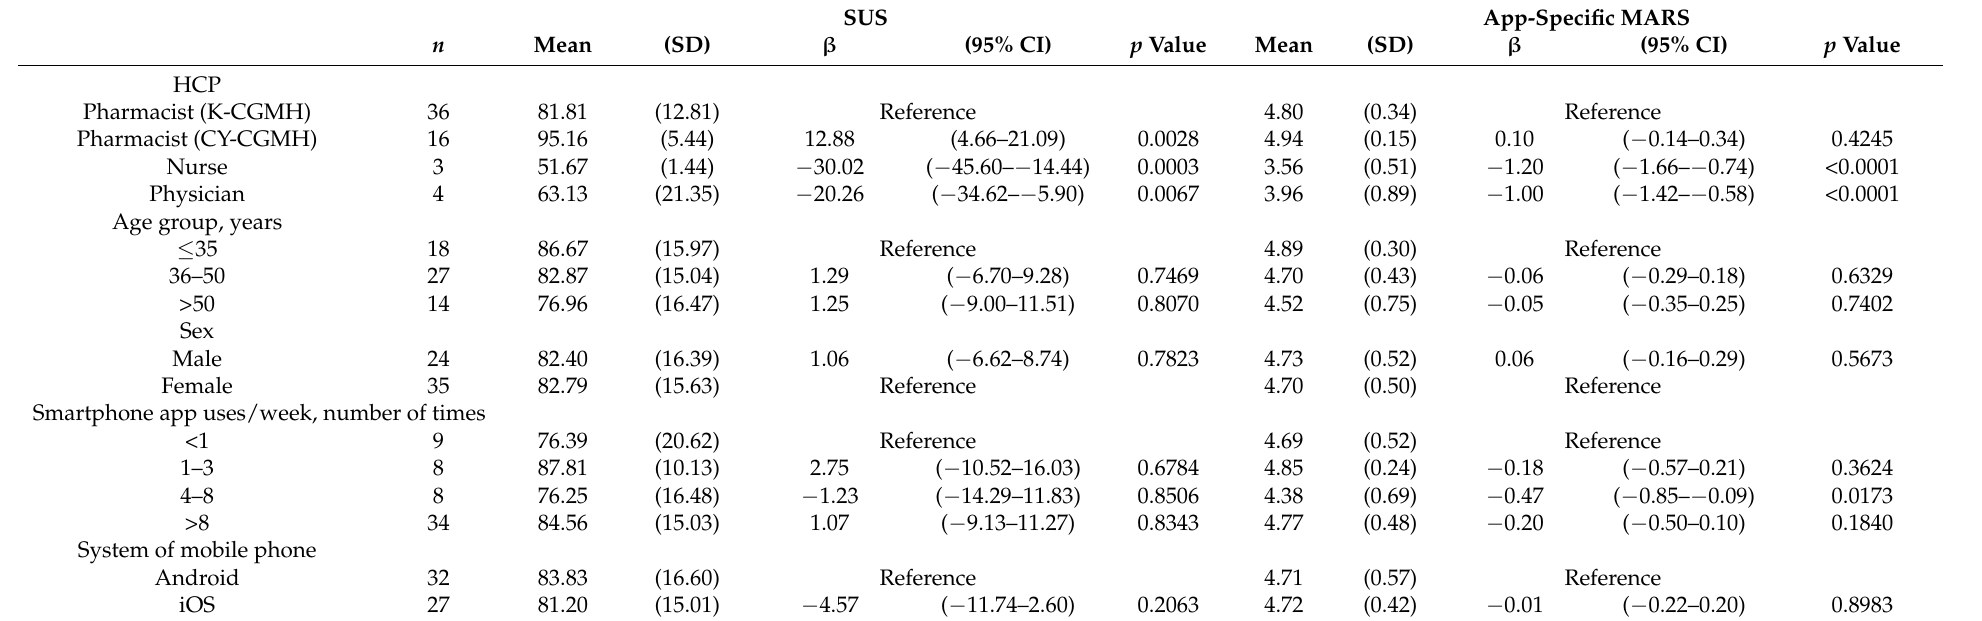
Table 4. Factors associated with healthcare professional’s evaluation of the